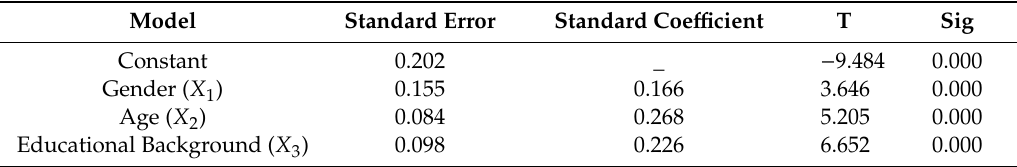
Table 5. The main factors influencing farmer’s